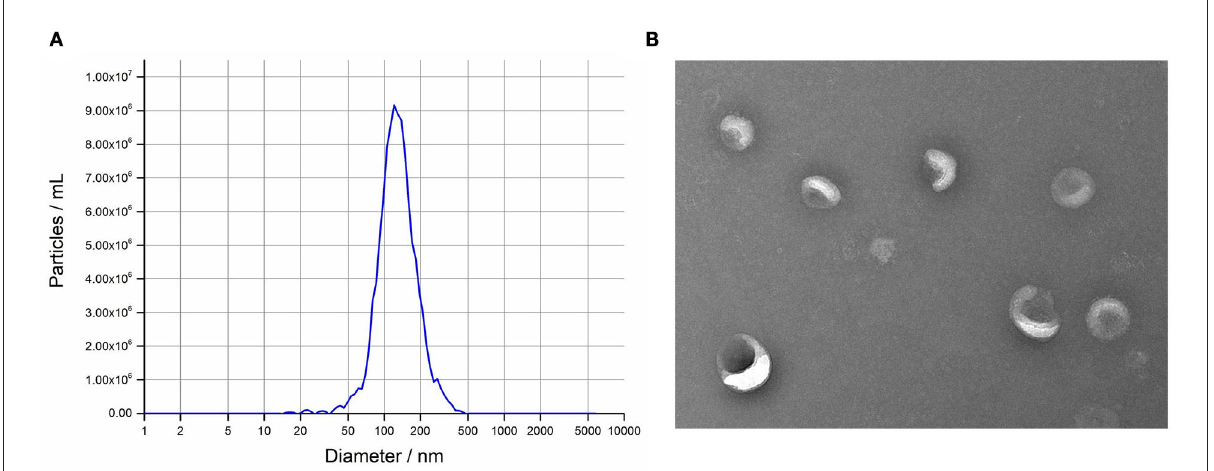
FIGURE1 Isolation and characterization of intrauterine exosomes. (A) Transmission electron microscopy images showed that the isolated vesicles were oval or bowl-shaped. Scale bar, 200nm. (B) Nanoparticle tracking analysis results demonstrated that the particle size distribution was in exosome-enriched